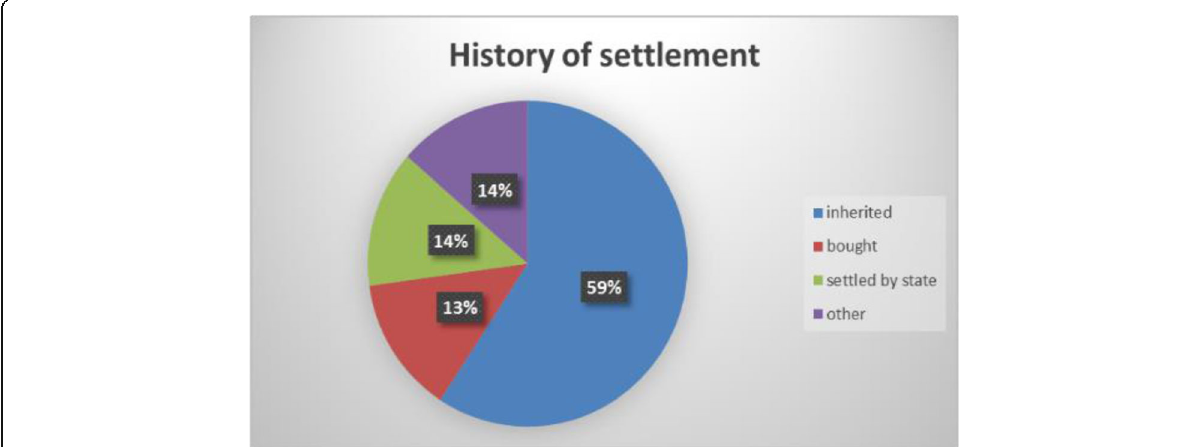
Fig. 3 History of settlement of the respondents in Gudo Beret